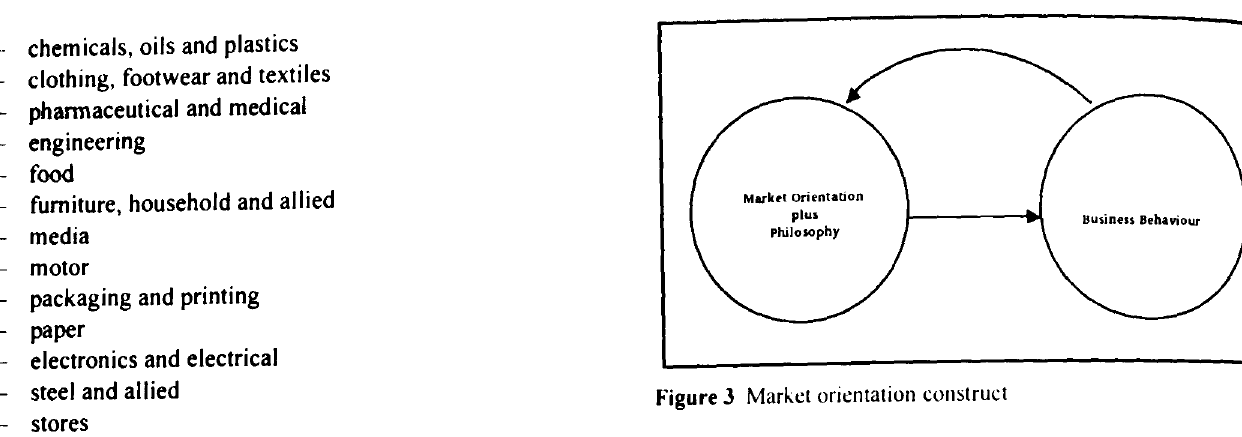
Figure J Market orientation